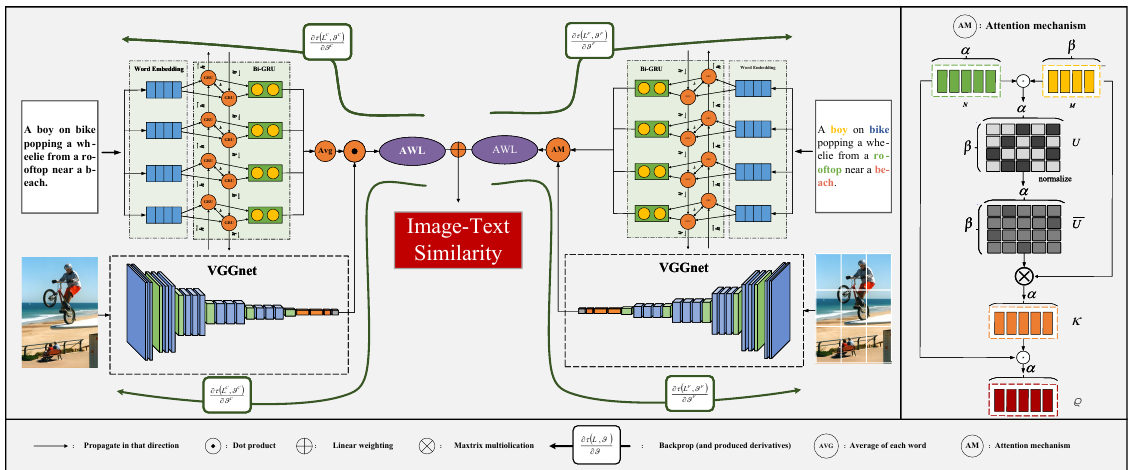
Figure 4. The deep learning network architectures of